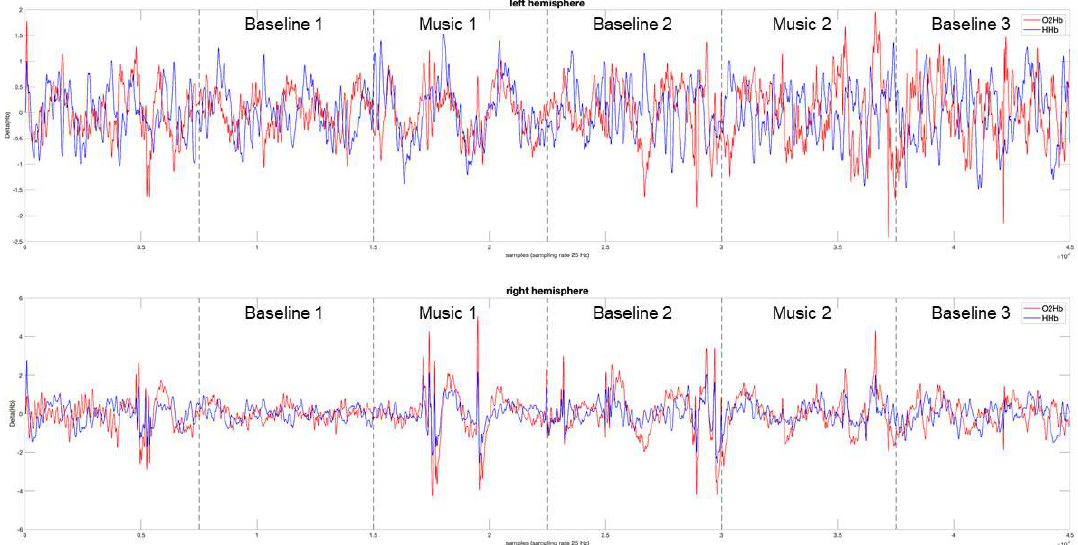
Figure A1. Example of time course fNIRS signal after the initial bandpass filter (0.007–0.4 Hz) for oxyhemoglobin (O2Hb) in red and deoxyhemoglobin (HHb) in blue, during the experiment in subject 6. On the y –axis is represented the variation (delta) in the concentration of O2Hb and HHb; on the x –axis are shown the samples (at sampling frequency of 25 Hz). Each experimental block is marked by a dashed line. At the top is demonstrated the signal on the left hemisphere; at the bottom is the signal on the right hemisphere.